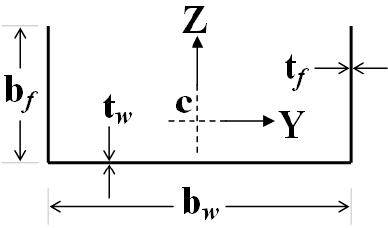
Figure 2. Geometrical details of the plain channel section.